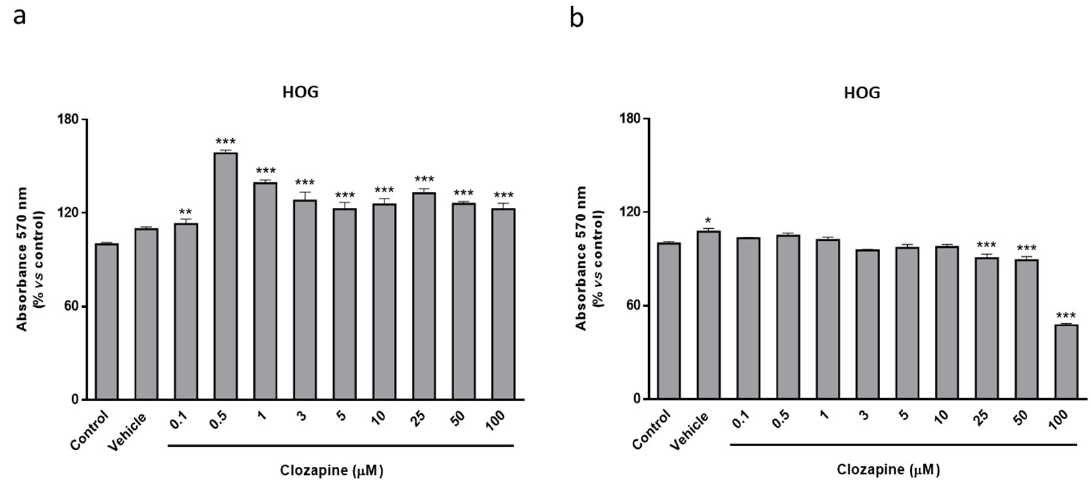
Figure A1. MTT assay in HOG cells treated with increasing concentrations of CLO (0.1–100 µM) during 24 h ( a ) and 48 h ( b ). Cell damage is represented as the percentage of viability versus control. Data are the mean ± SEM of five independent experiments. Significant differences were analyzed by a one-way ANOVA followed by post-hoc Tukey’s test. * p < 0.05, ** p < 0.01, *** p < 0.001 compared with control.